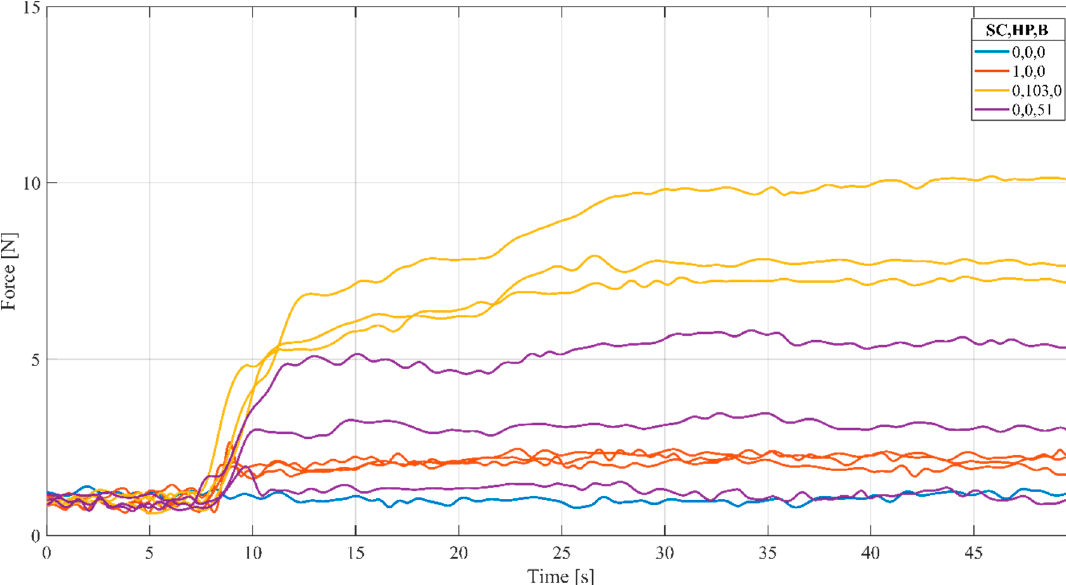
Figure 7. Force–time history of same volume cases and comparison with the base case without debris. The debris category is displayed in colors. The number of each type of debris is displayed within the legend (SC,HP,B).